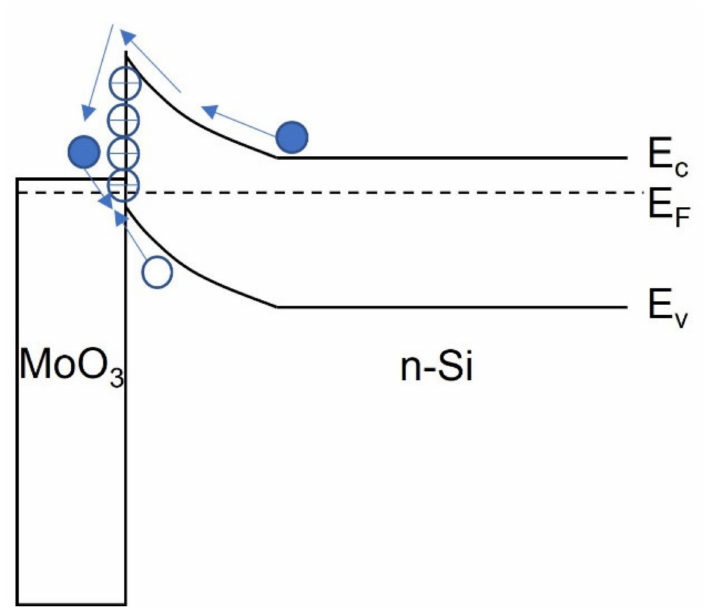
Figure 9. Hole selectivity mechanism of the MoO 3 /n-Si passivating contact involving electron excitation over barrier, negative fixed charge and recombination with